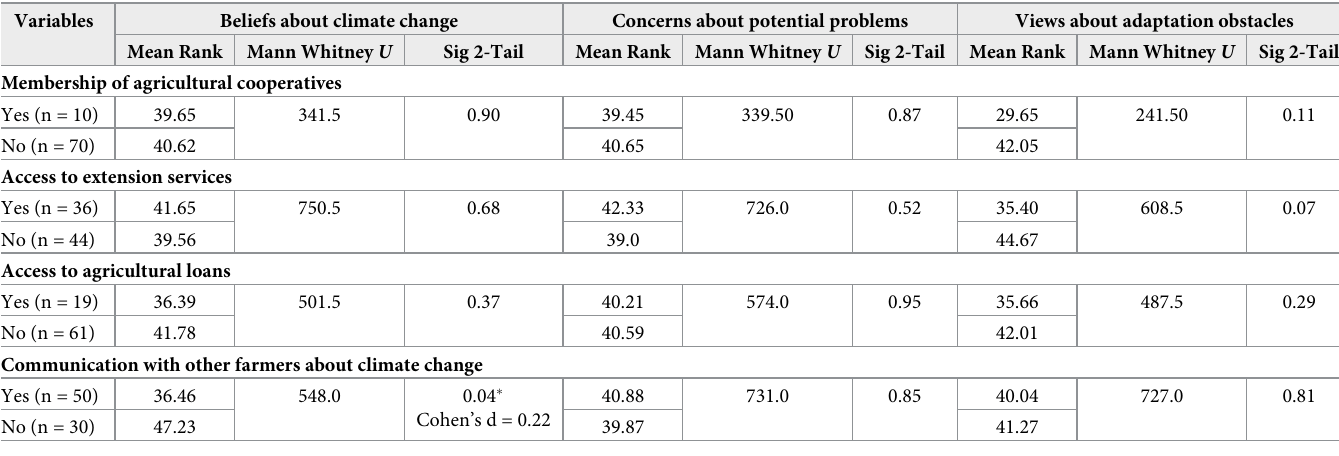
Table 6. Mann Whitney test for differences in beliefs and concerns about climate change and views about adaptation obstacles. Variables Beliefs about climate change Concerns about potential problems Views about adaptation